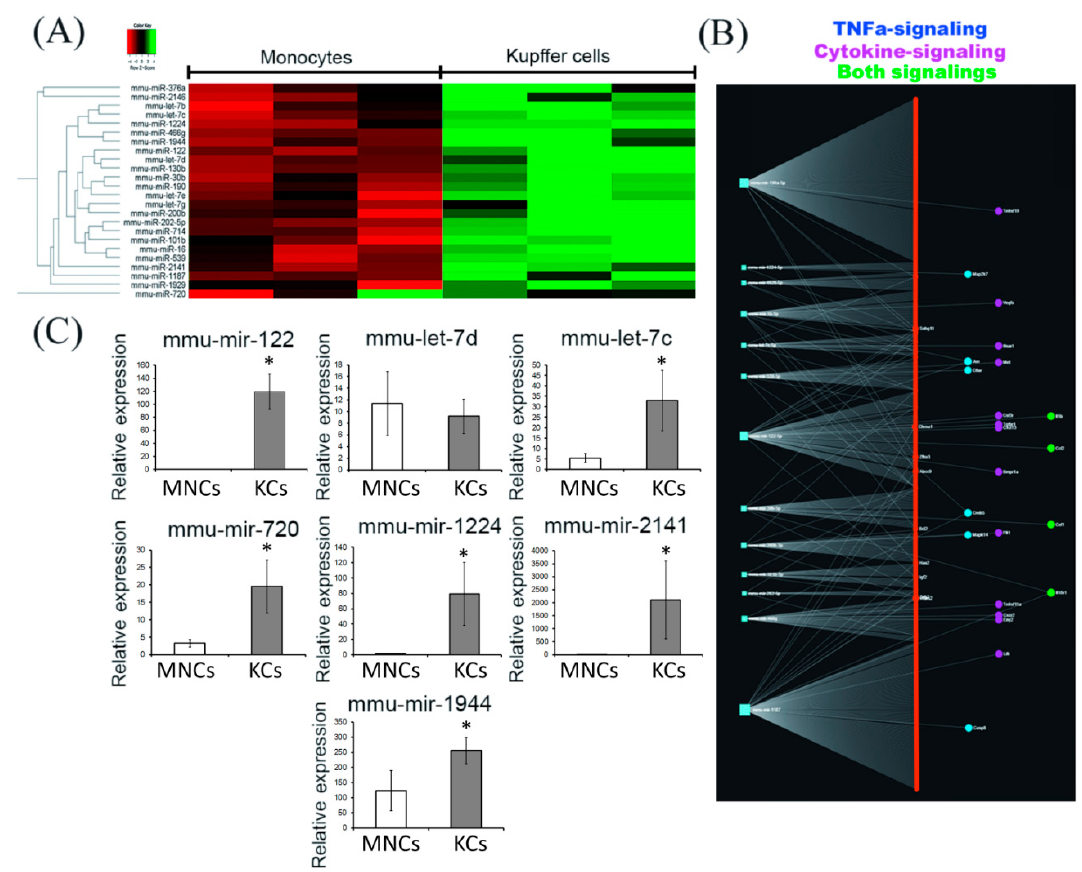
Figure 3. The analysis of miRNA expression in monocytes and Kup ff er cells. Heatmaps depict relative expression levels of miRNAs ( A ). Full-length heatmaps are listed in Figure S3. The miRNAs with higher expression levels in Kup ff er cells, are shown with their highly correlated targets that are predicted by TargetScan and miRNet. The colour labels are blue (genes of TNFa-signalling), pink (cytokine signalling), and green (both types of signalling) ( B ). miRNA expression profiles (PCR-RT) for MNCs and KCs ( C ). The data is presented as means with the bars for standard deviations. Data is listed as mean ± standard deviation. * p < 0.05 monocytes vs Kup ff er cells. KCs: Kup ff er cells; MNCs: monocytes.